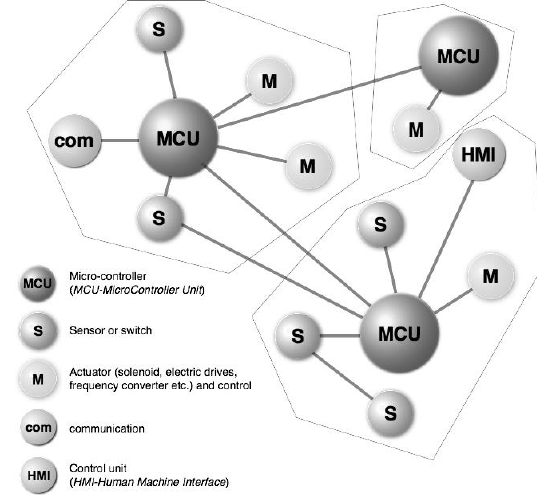
Fig. 1. Visual example of electro-technological molecule